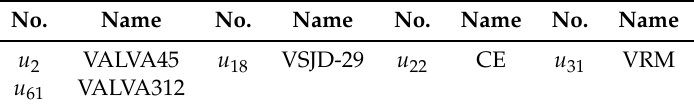
Table 2. Structural actuators (towards demands).